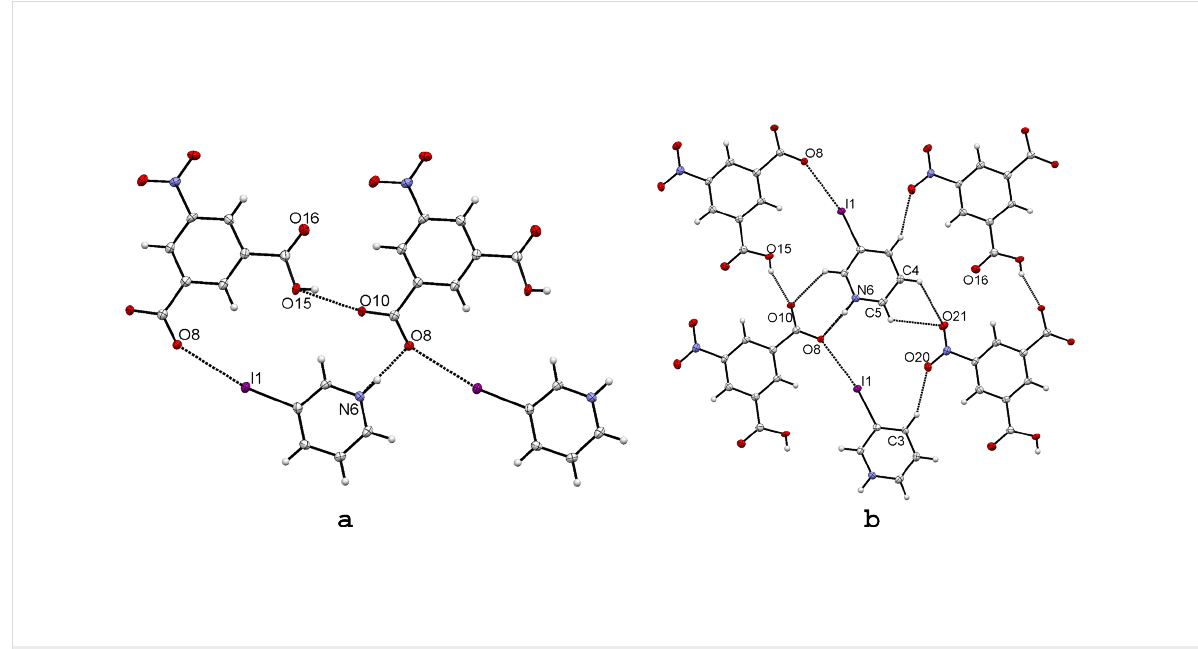
Figure 7: X-ray structure of 3-IPyH-5-NIPA ( 13 ) with selected numbering scheme of the asymmetric unit (a). A selected part of the packing is shown on (b). Thermal ellipsoids are drawn at the 50% probability level. Hydrogen and halogen bonds are shown in dotted lines. The contact distances and angles are; [I1···O8] 2.999(2) Å and 170.0(1)°, [N6–H···O8 x 1, y+1, z ] 2.625(3) Å and 175(3)°, [O15–H···O10] 2.586(2) Å and